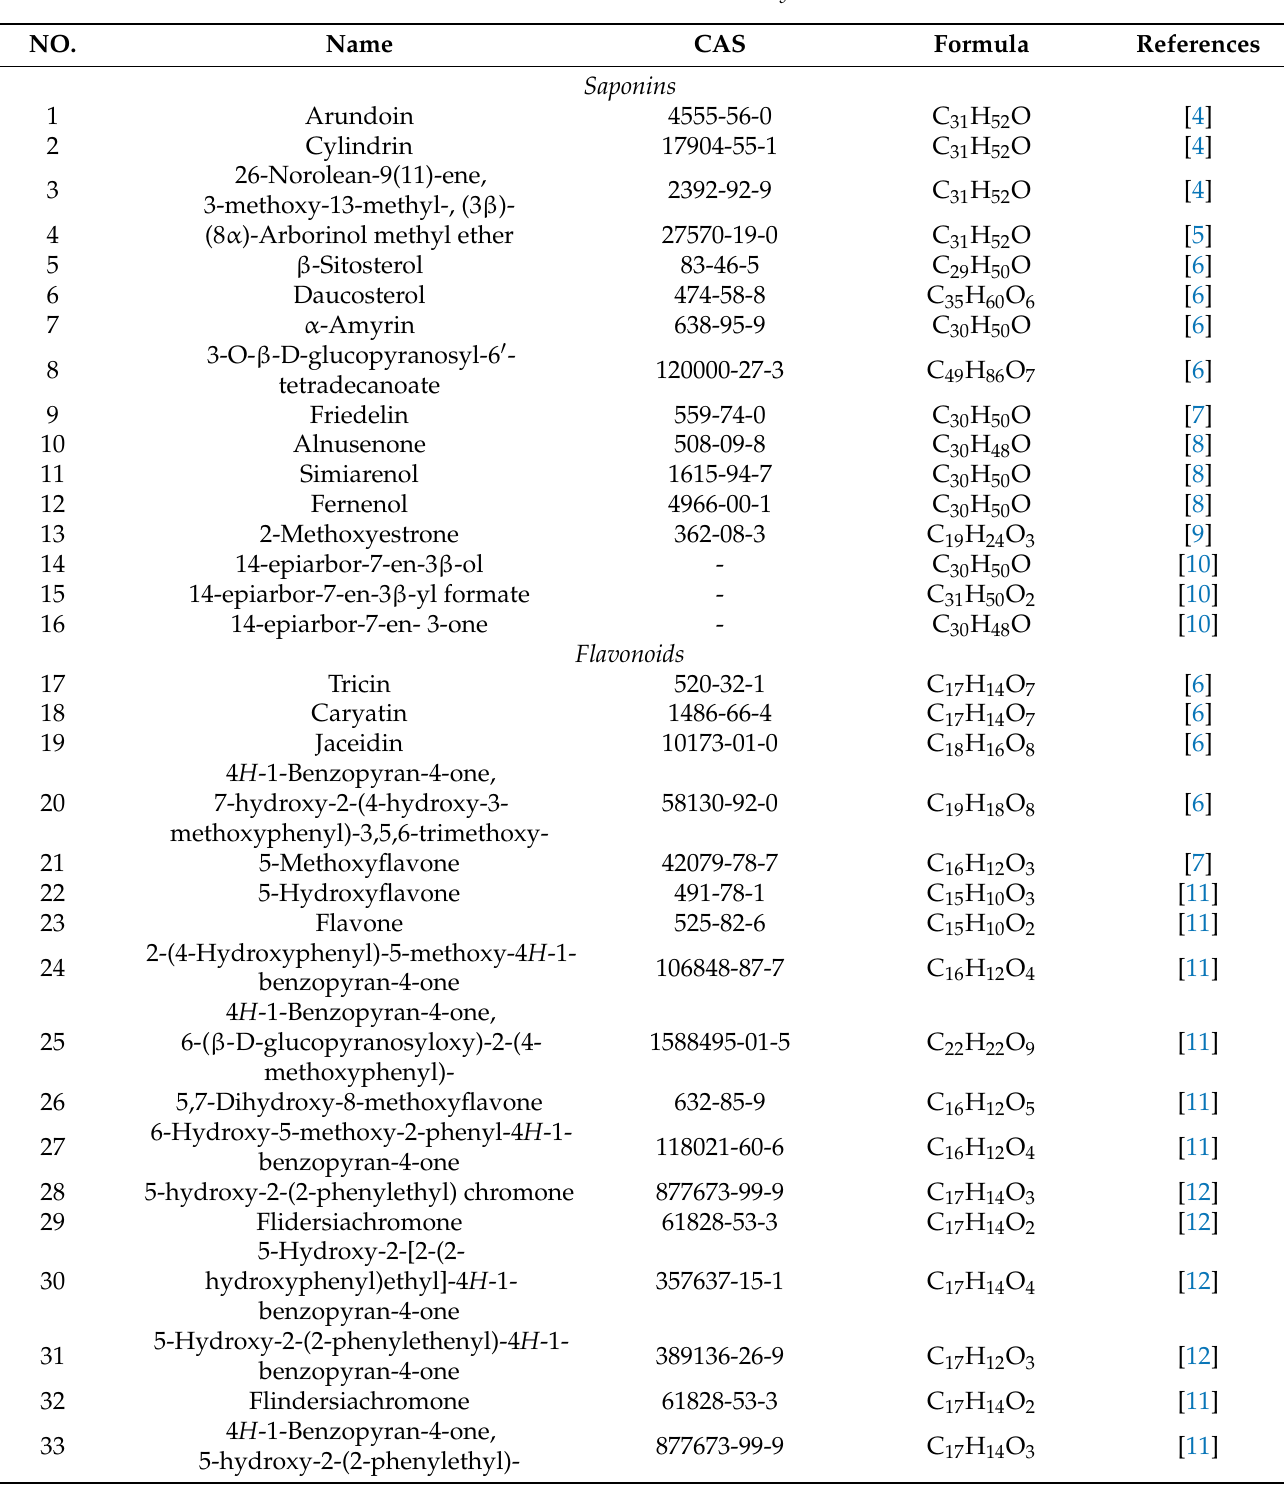
Table 1. Constituents isolated from I.